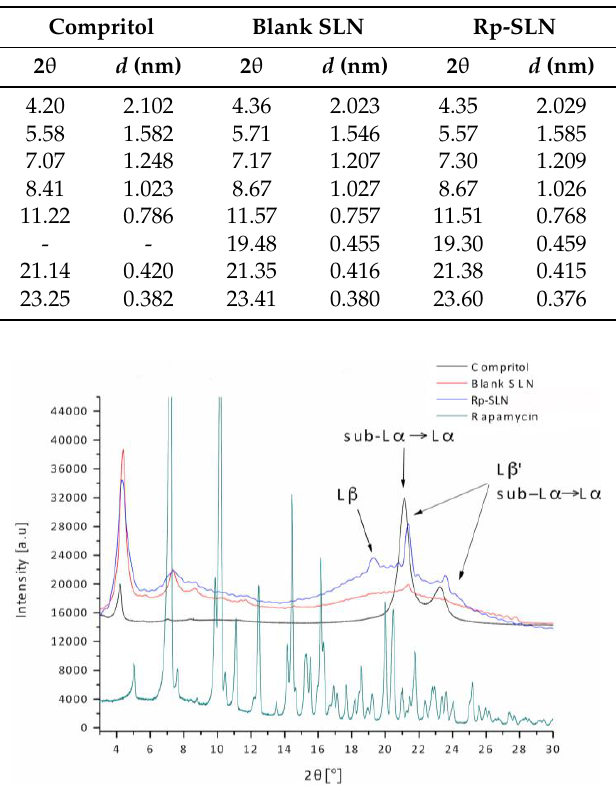
Figure 6. WAXS profiles of pure Rp, compritol and blank and Rp-SLN. Arrows indicate the signals corresponding to the polymorphs observed for blank, Rp-SLN and bulk lipid.